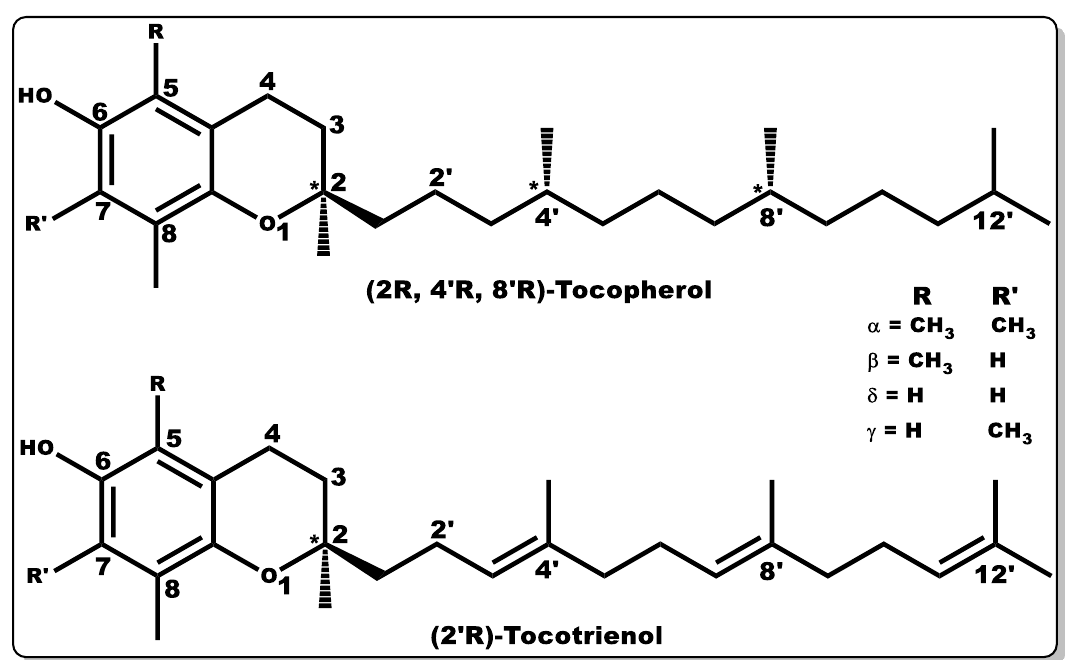
Figure 9. Molecular structures of tocochromanols (tocopherol and tocotrienol). Various isoforms of tocochromanols vary at position 5 or 7 (R or R’) of the chromanol ring with either -H or -CH 3 moieties. In addition, the side chain of both tocochromanols differ, with tocopherol having a saturated chain while tocotrienol possess unsaturated side chain (double bond) at positions 3′, 7′, and 11′.